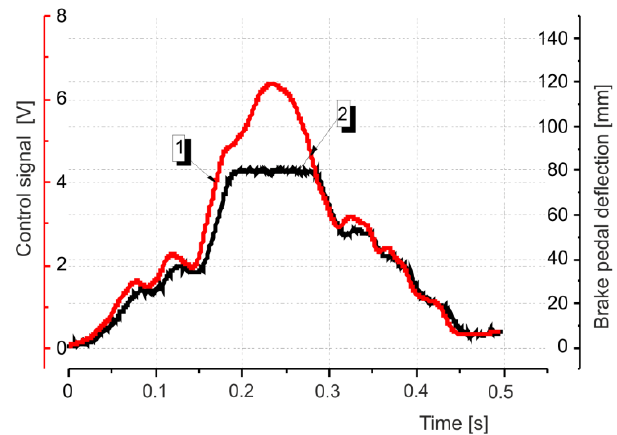
Figure 12. Test results on the test bench: 1–control signal based on the Lowess method filter (LM), 2–brake pedal deflections measured with a laser sensor.